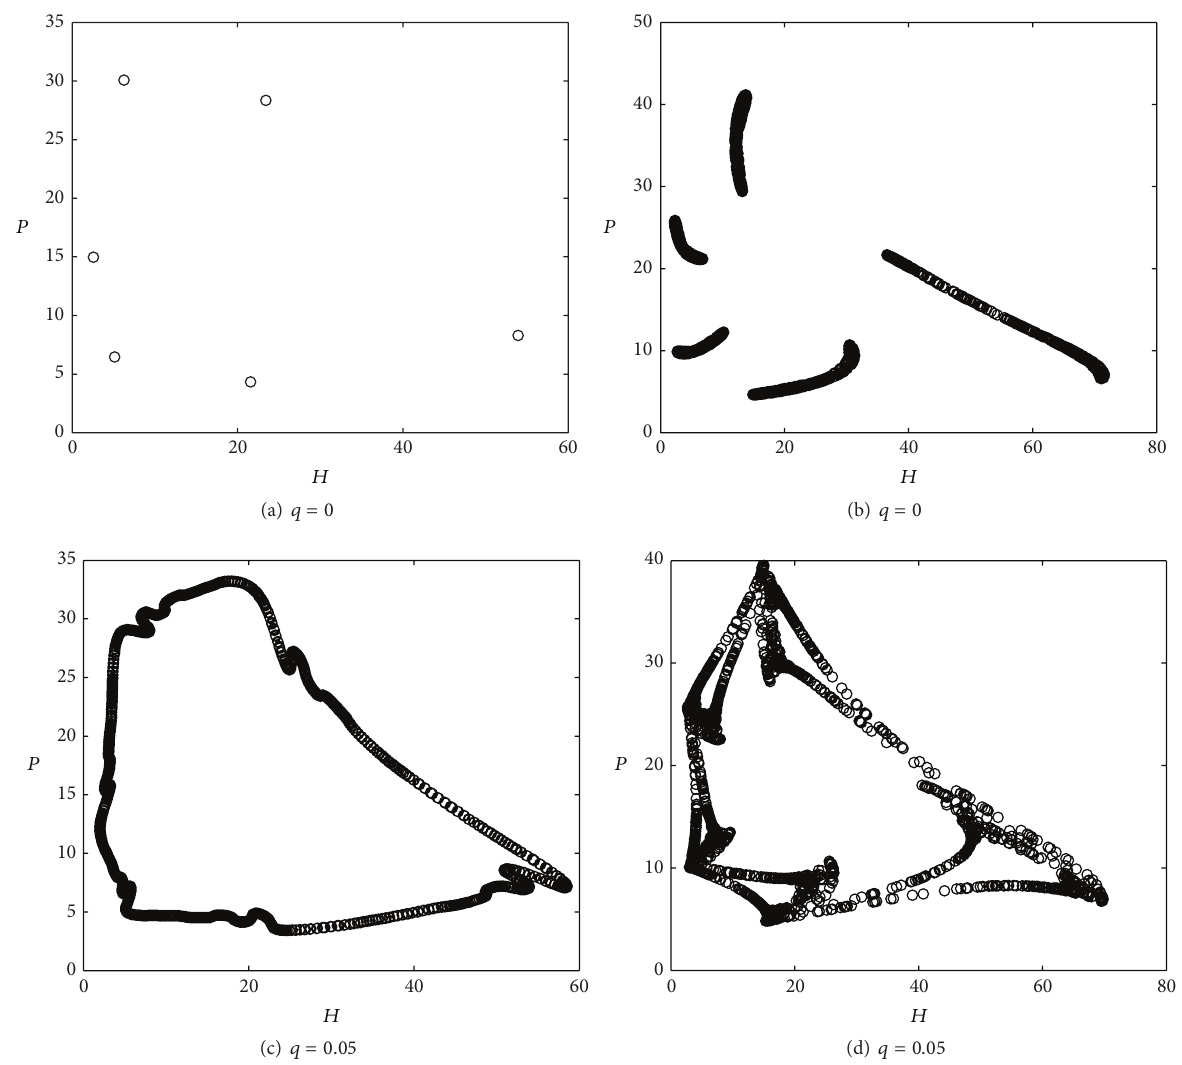
Figure 5: Attractors of model (4) for different parameter values 𝑟 and 𝑞 . The parameter values are as follows: 𝑇 = 10 , 𝑇 ℎ = 0.5 , 𝐾 = 50 , 𝛿 = 0.3 , 𝛾 = 1 , 𝛼 = 0.01 , 𝜃 = 0 , and 𝑞 = 0 in (a-b), 𝑞 = 0.05 in (c-d), 𝑟 = 2.3 in (a, c), and 𝑟 = 2.84 in (b,